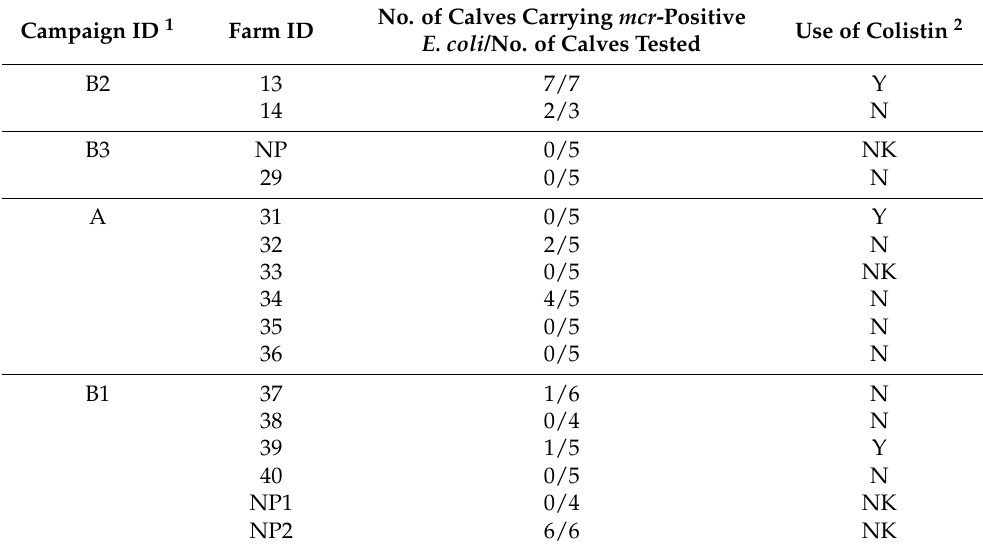
Table 2. Distribution of sampled calves according to campaign, farm, number of calves carrying mcr -positive E. coli and use of colistin in